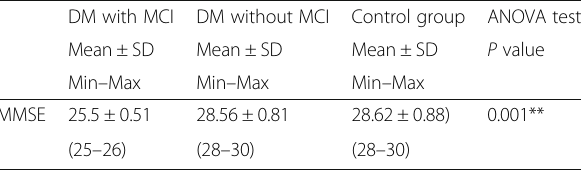
Table 1 The results of cognitive assessment among the study groups